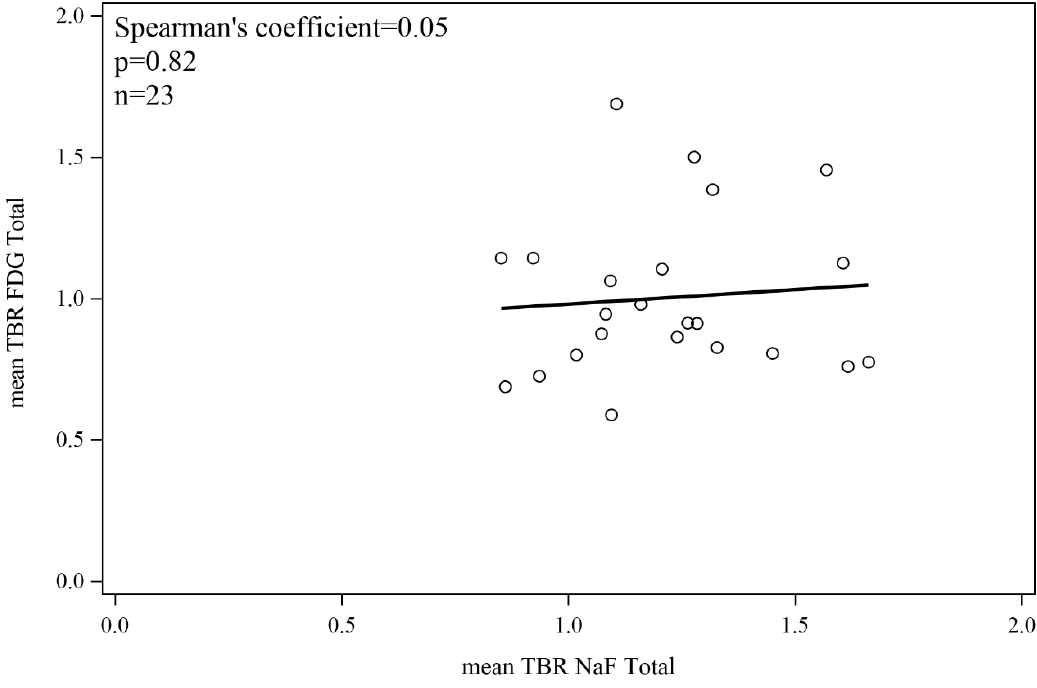
Figure 5. Correlation between 18F-FDG and 18F-NaF uptake in artery walls.